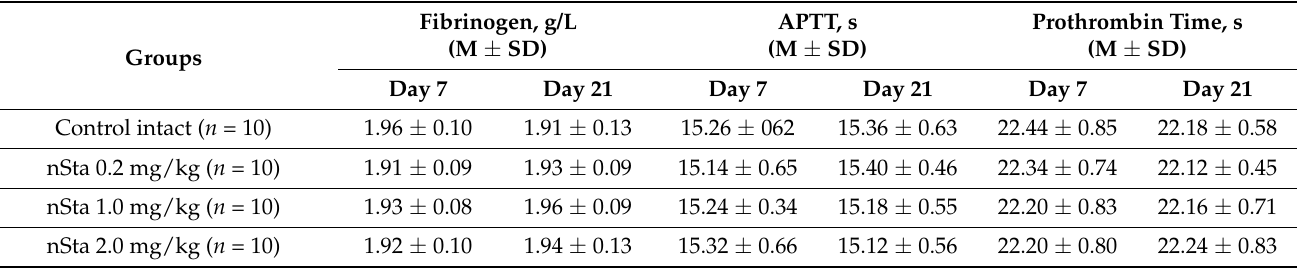
Table 1. Effect of inhaled nSta on coagulation parameters.